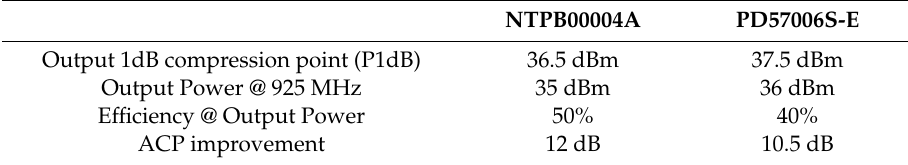
Table 3. Adjacent channel power (ACP) improvement using a 20 neuron neural network.